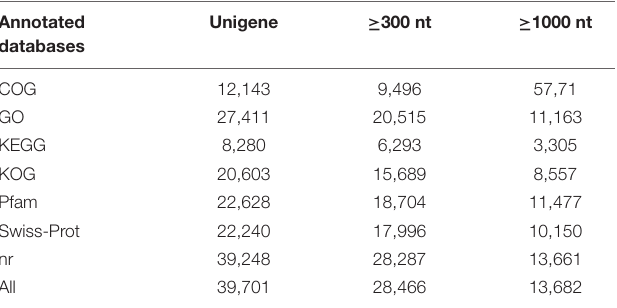
TABLE 3 | Summary of unigene